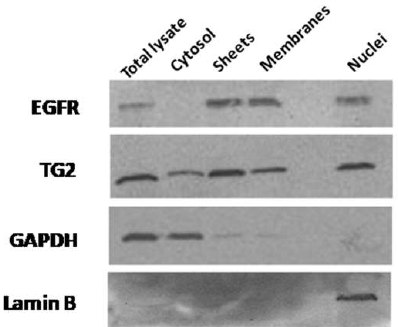
Figure 1. Subcellular fractionation of TG2 in primary fibroblasts. Western blot analysis showing TG2 levels in subcellular fractions of one representative sample (from a CD culture). The identity of each fraction was verified by analyzing the expression of specific markers, such as the EGF-receptor (EGFR) for membrane fractions (sheets and membranes), GAPDH for the cytosol, and lamin B for the nuclear fraction.